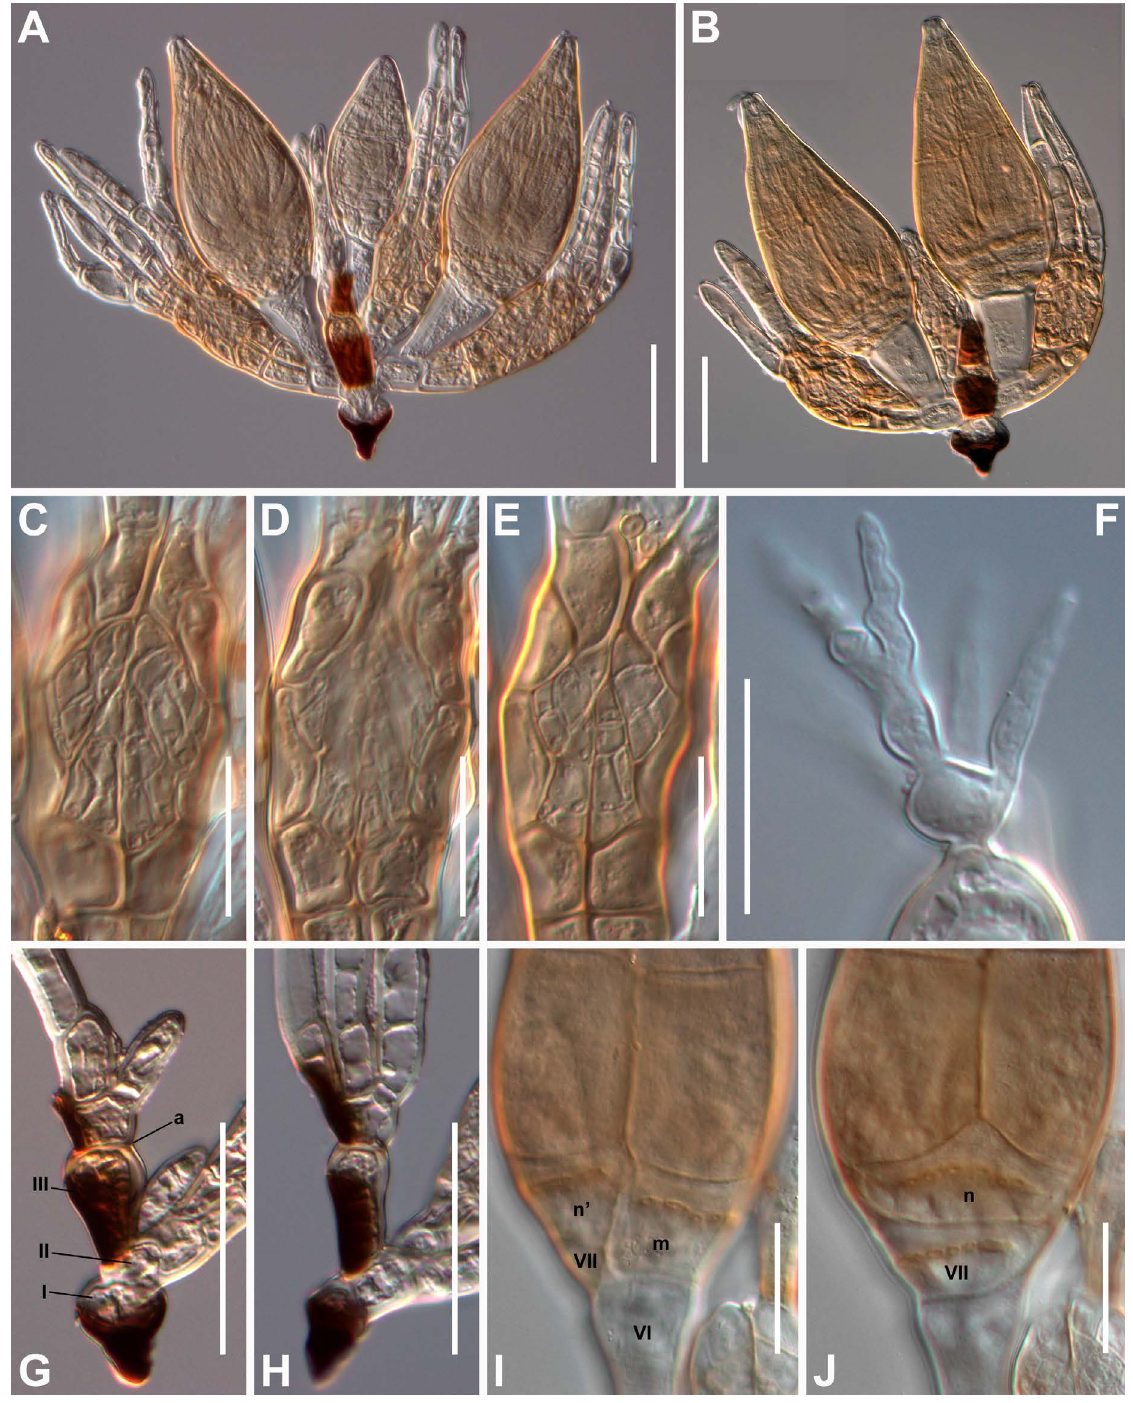
Fig. 86. Monoicomyces homalotae Thaxt. A – B . Mature thalli. C – E . Respectively, near, middle and far focus of antheridium in detail. In D, the middle focus, phialides and spermatia can be seen. F . Trichogyne in detail. G – H . Lower receptacle (I, II, and III) and base of primary appendage in detail; the primary septum (a) is labelled in G. I – J . Perithecial base in two focusing levels to see basal cells (m, n, n’), secondary stalk cell (VII), and stalk cell (VI). Scale bars: A–B, G–H = 50 µm; C–F, I–J = 20 µm. Photographs from slides ZMUC C-F-123255 (A), ZMUC C-F-122687 (B), ZMUC C-F-123046 (C–E), ZMUC C-F-123757 (F), ZMUC C-F-123020 (G), ZMUC C-F-123492 (H), ZMUC C-F-123793